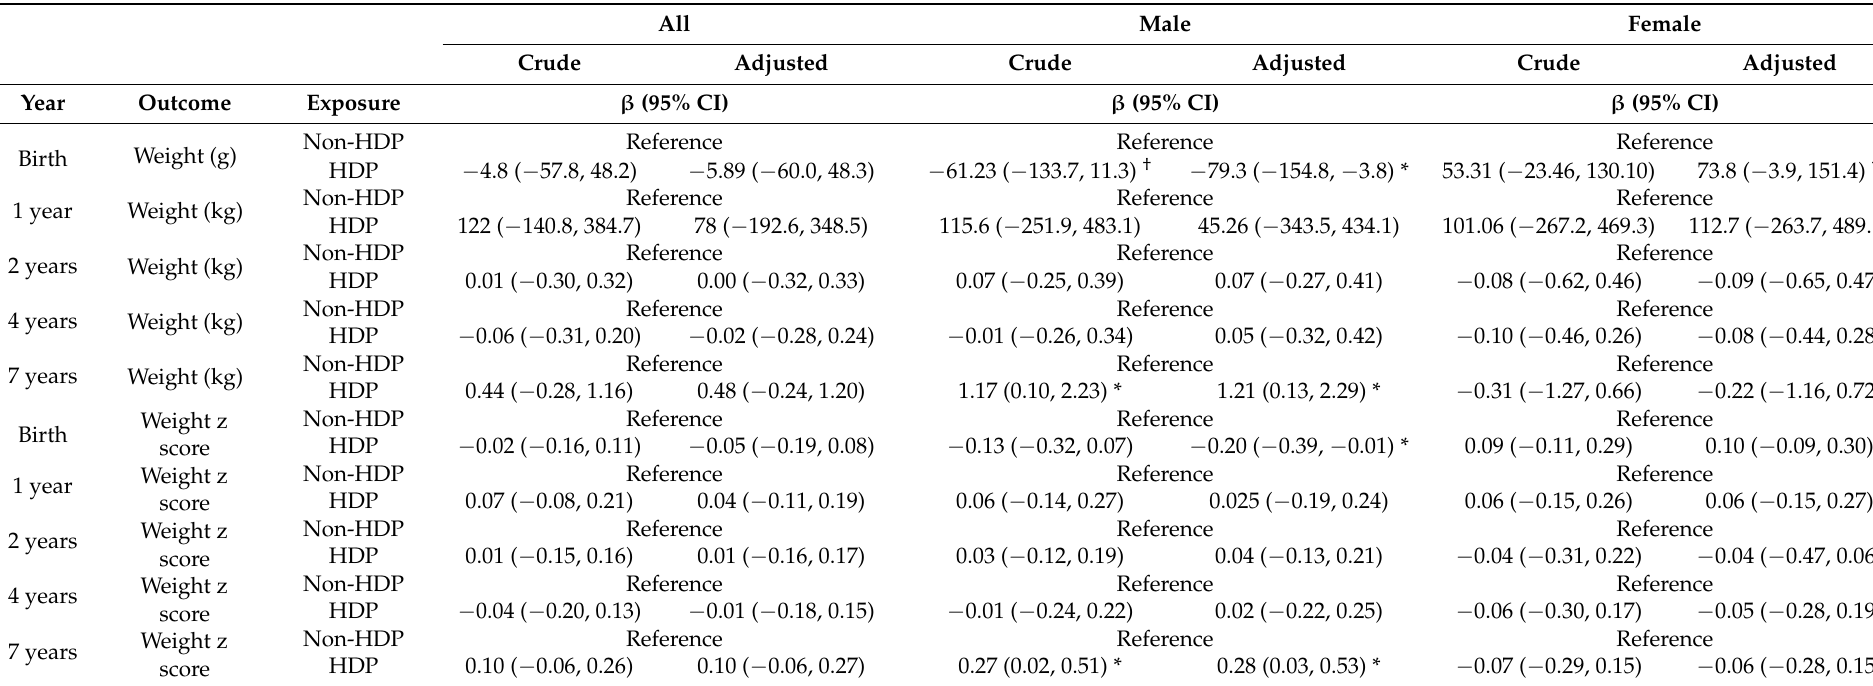
Table 4. Association between hypertensive disorders during pregnancy and weight during different periods of age using the multiple linear regression models. All Male